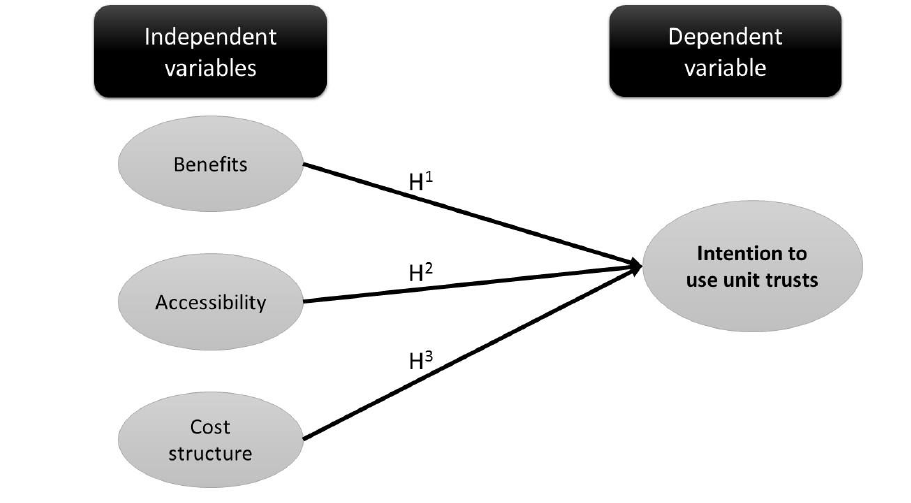
FIGURE 1: Hypothesised model of selected variables influencing the intention to use unit trusts Source: Researchers’